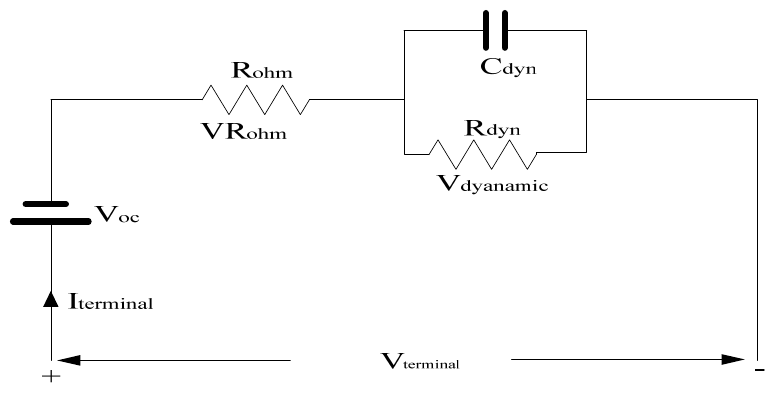
Figure 2. Battery model.